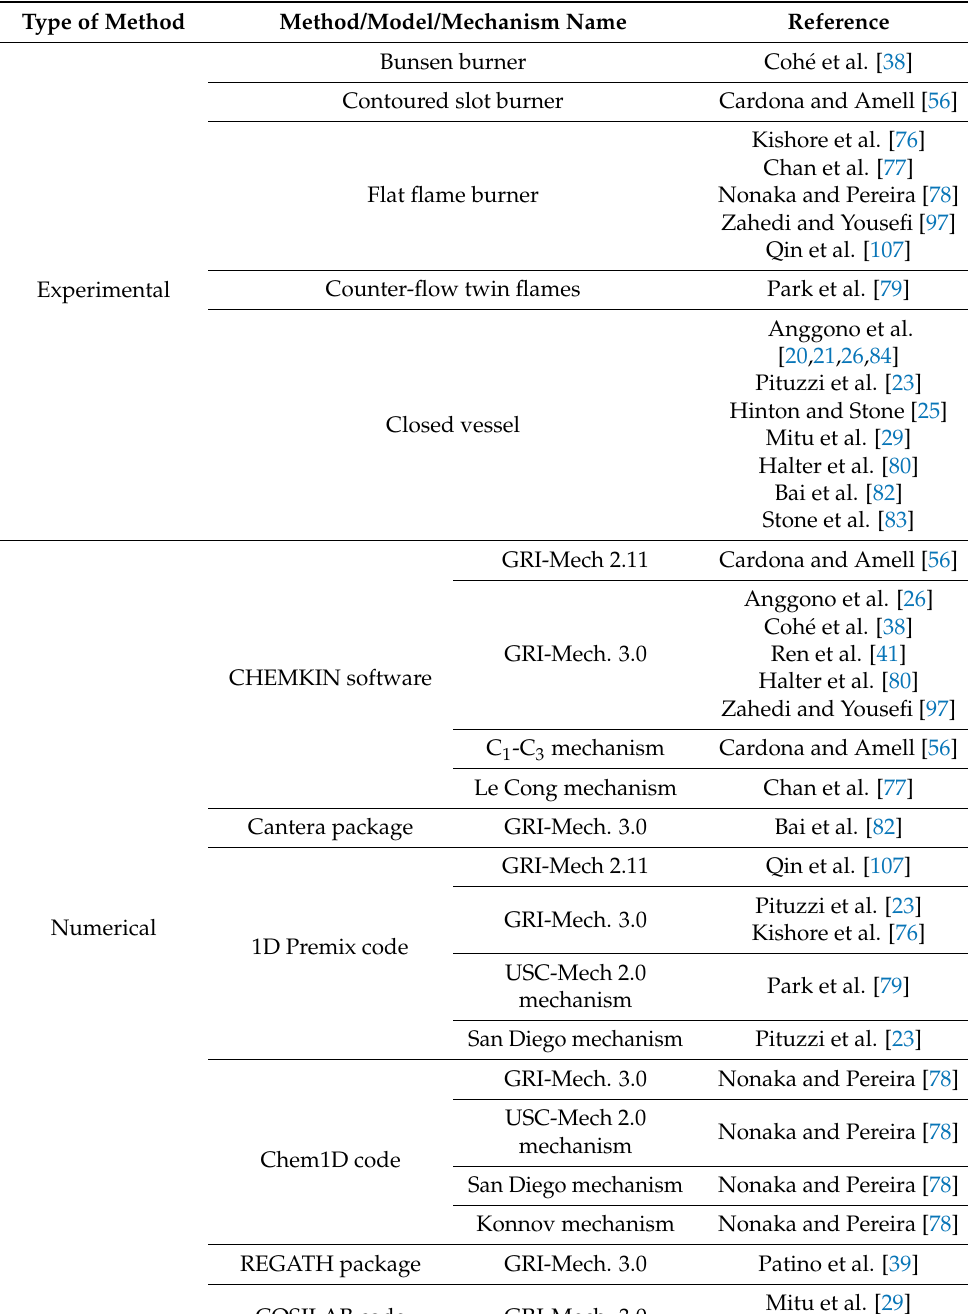
Table 4. Summary of experimental and computed methods for obtaining the laminar burning velocity of biogas-air mixtures presented in the present